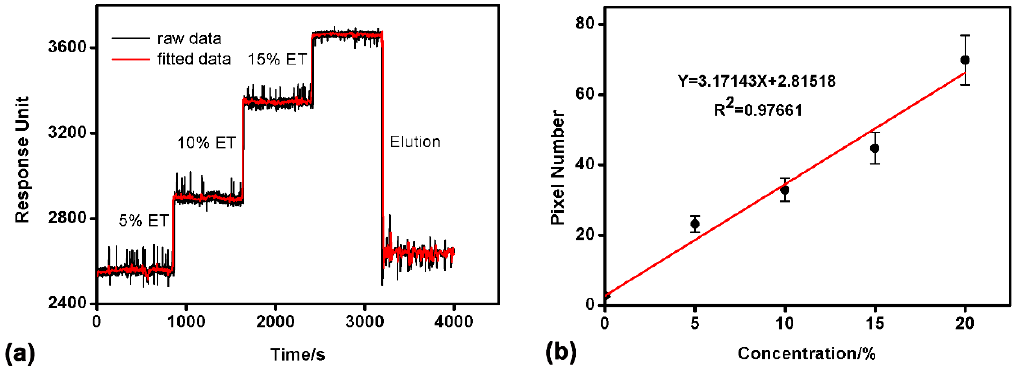
Figure 3. Ethanol detection in the SPR device. ( a ) SPR response of variable ethanol concentrations from 5% to 15% (Ethanol: ET); After washing, the SPR response curve almost returned to the baseline; ( b ) the calibration curve of variable ethanol concentrations. The fitting relationship is Y = 3.17143 X + 2.81518, the goodness of fit R 2 = 0.97661 (repeat times n = 10).